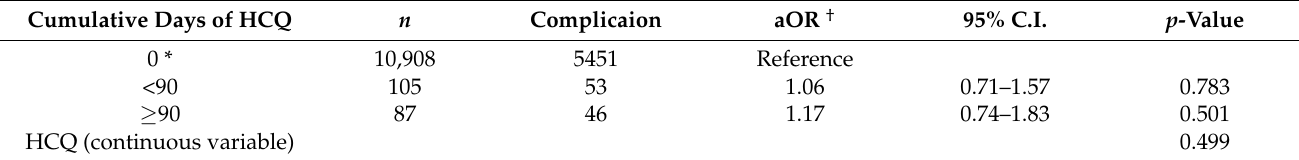
Table 4. Risk of ophthalmic complications with different cumulative days of